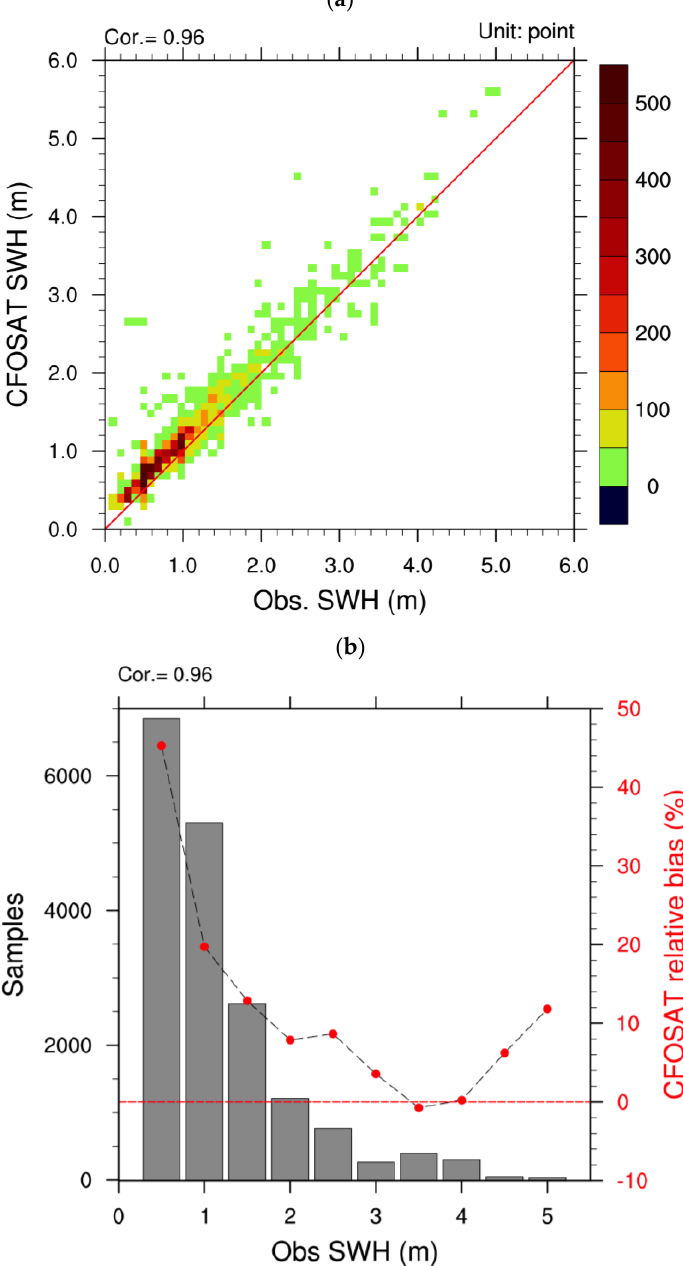
Figure 2. Scatter − point density plot of the CFOSAT SWH versus that of 23 buoys ( a ) and the relative bias according to the SWH of buoys in intervals of 0.5 m with samples numbers, where red dots indicate the relative bias of CFOSAT SWH against observation ( b ). The temporal and spatial windows are 30 min and 50 km, respectively, and 21,049 matched SWHs were used.